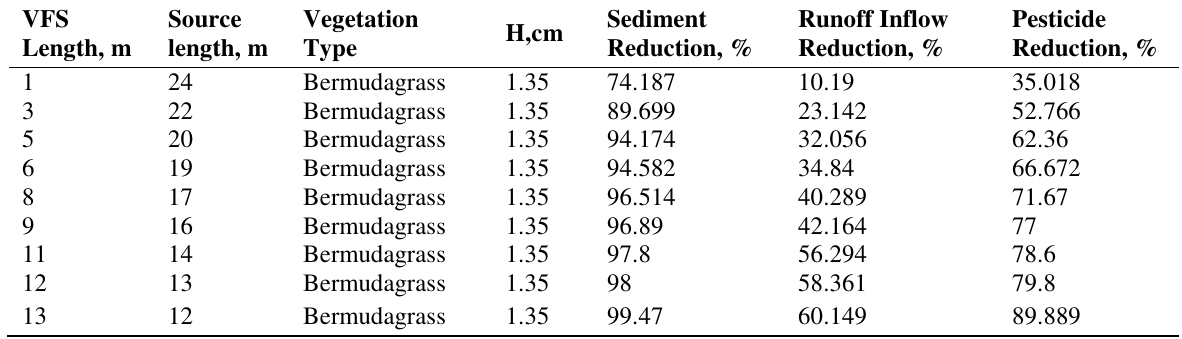
VFSMOD-W output file.